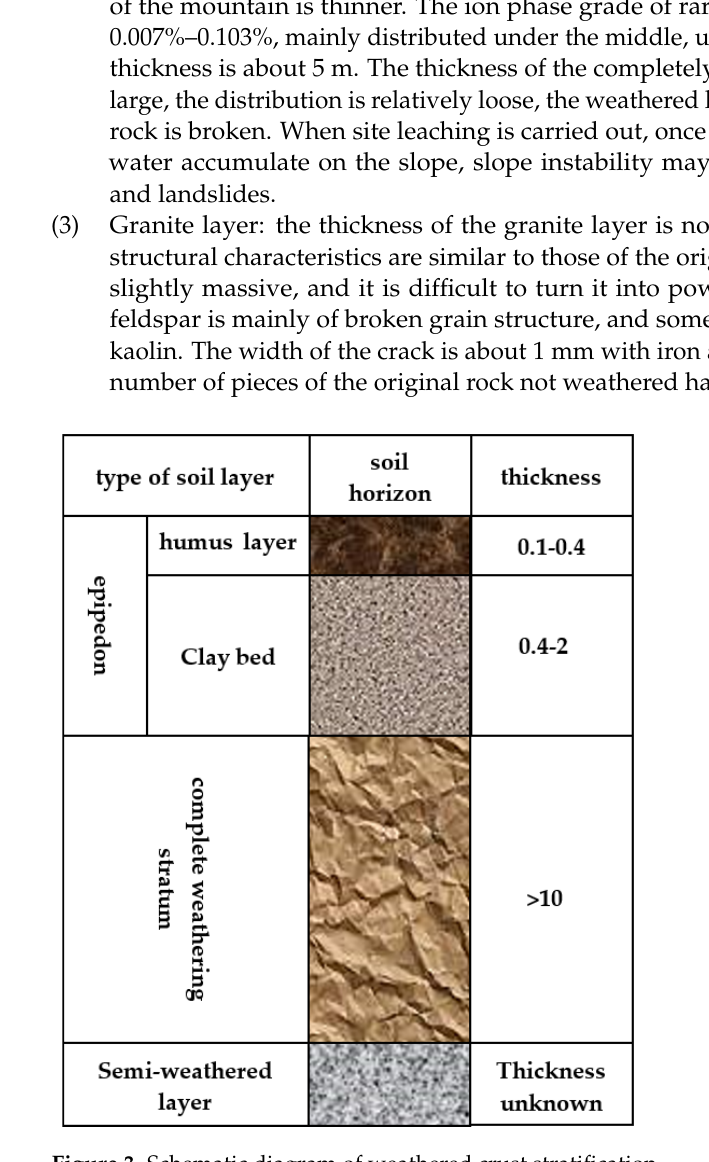
Figure 3. Schematic diagram of weathered crust stratification.